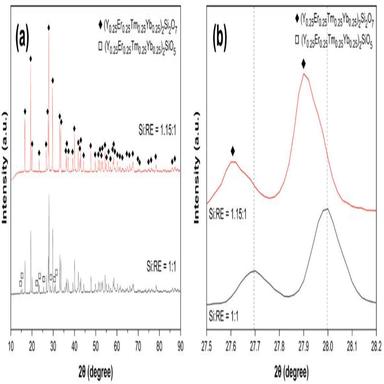
XRD patterns of thermally annealed quaternary (Y0,25Er0,25Tm0,25Yb0,25)2Si2O7 powders with different SiO2 additions over the range of (a) 2θ = 10–90◦ and (b) 2θ = 27.5–28.2◦.